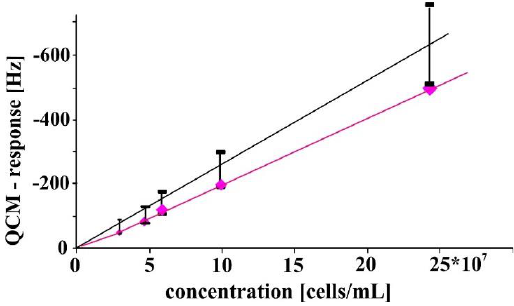
Figure 2. 10 MHz QCM frequency response of Escherichia coli bacteria as a function of cell Figure2. 10MHzQCMfrequencyresponseofEscherichiacolibacteriaasafunctionofcellconcentrations concentrations ( ♦ ), compared to AFM-measurements ( ɪ ) by counting adhered cells. ( (cid:7) ), compared to AFM-measurements ( I ) by counting adhered